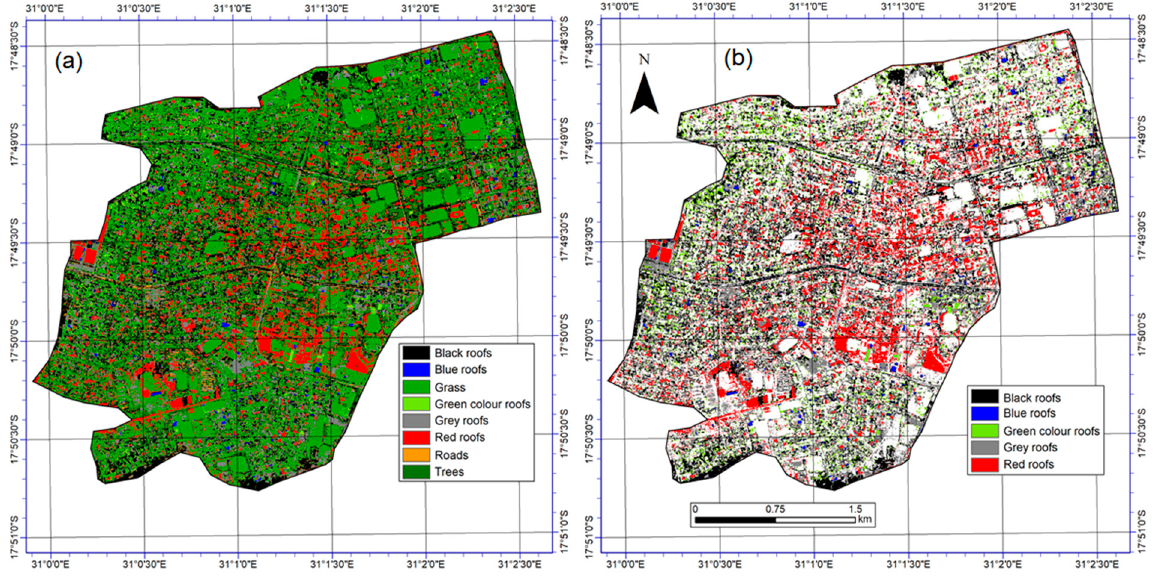
Figure 3. 10-m resolution ( a ) LULC map and ( b ) roof colour map.